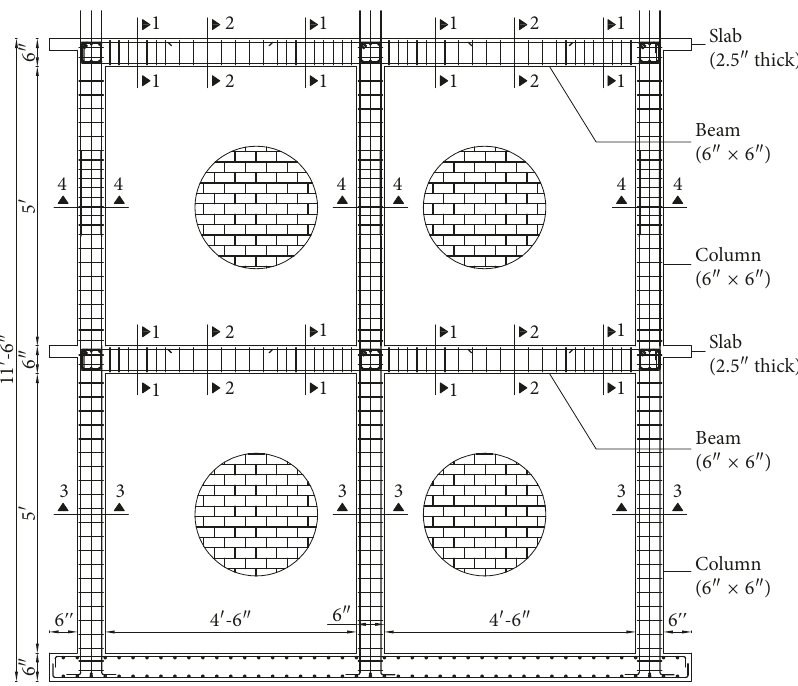
Figure 4: Design of the two-storey specimen (dimensions in